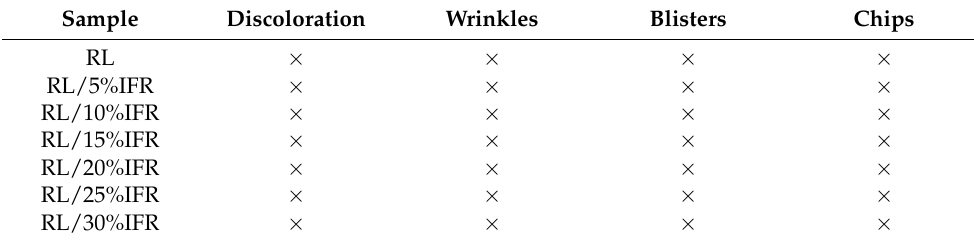
Table 6. Acid resistance of RL/IFR